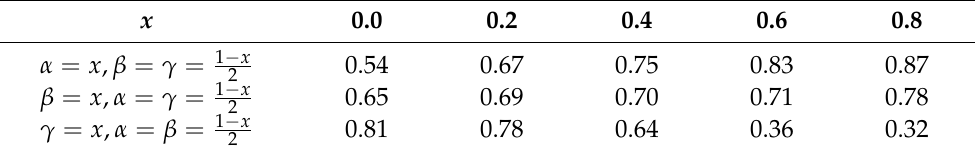
Table 11. Effect of varying α , β and γ using Non-IID MNIST under